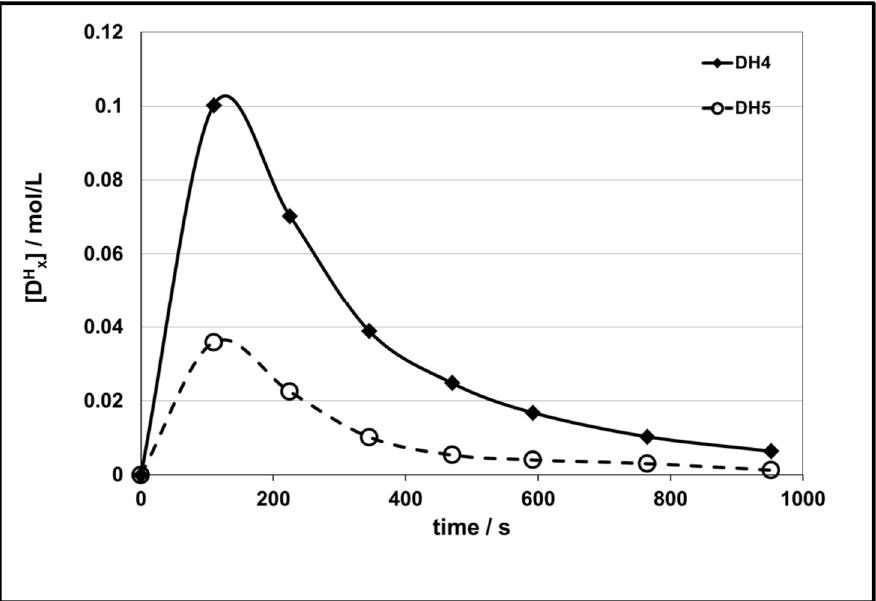
Figure 4. Cyclic oligomers’ formation and disappearance during the restructuring of PHMS in its 20% solution in toluene in the presence of 1 × 10 − 2 mol/L of (C 6 F 5 ) 3 B at 30 °C.